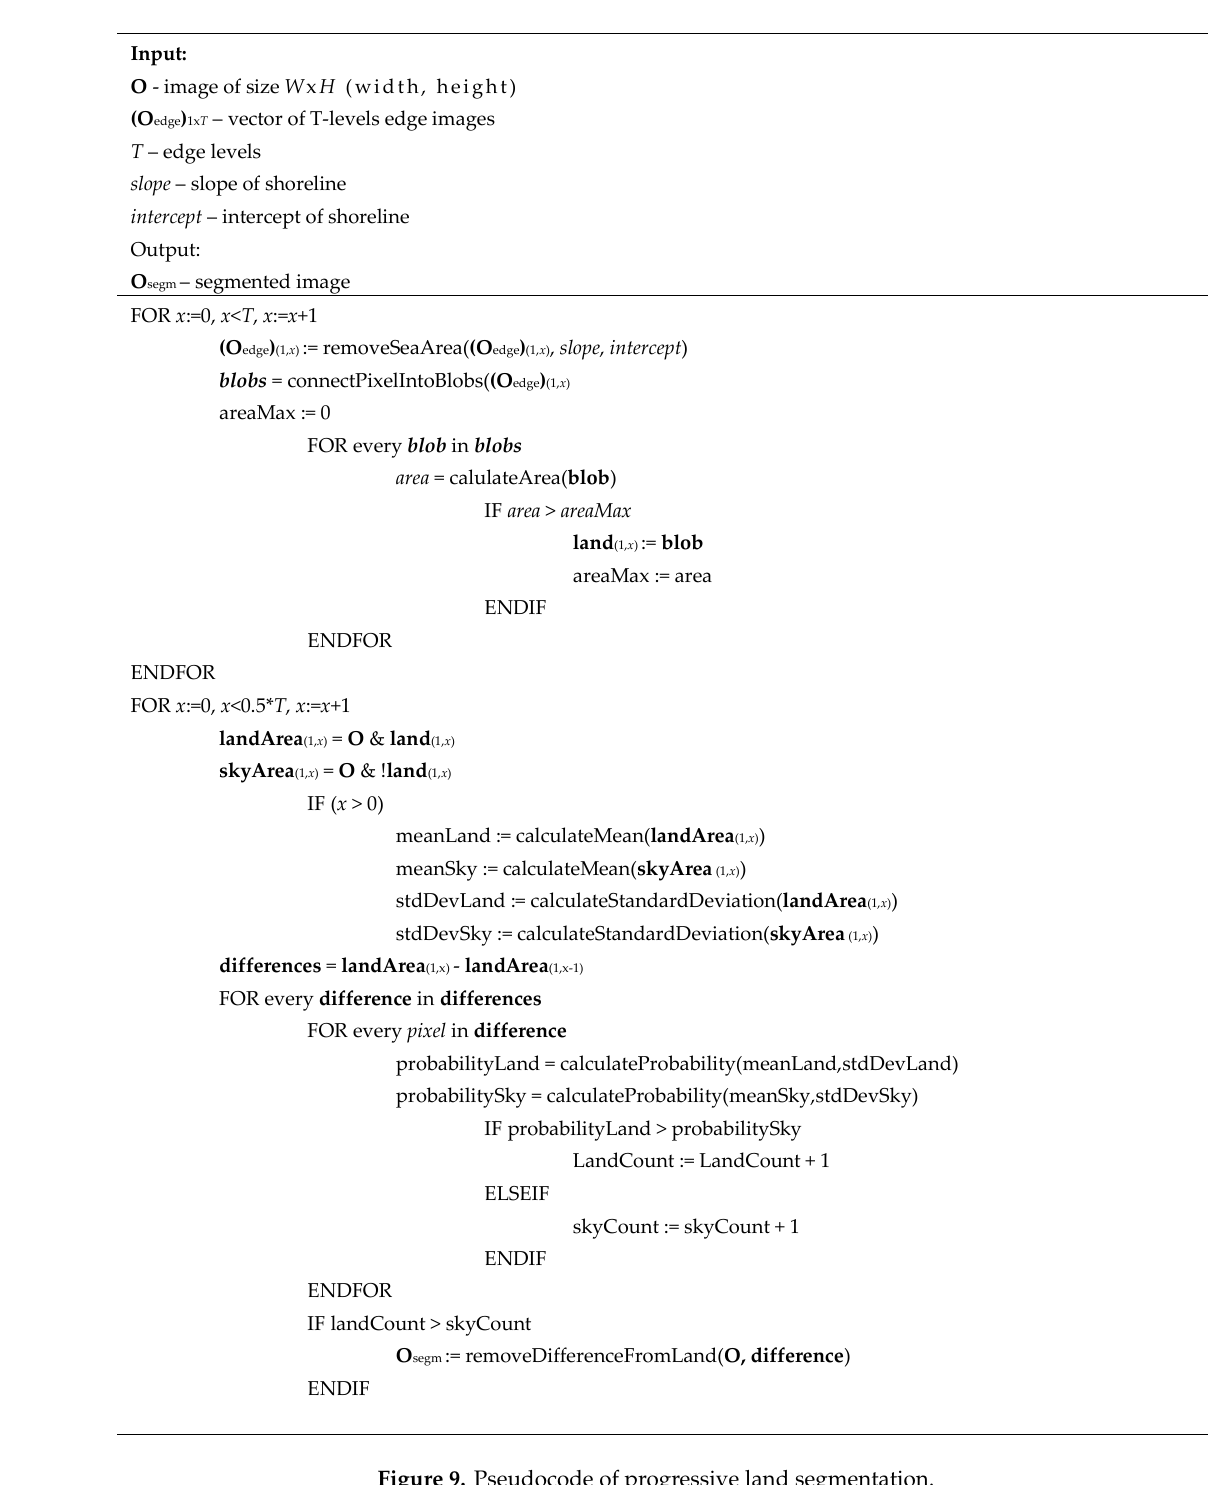
Figure 9. Pseudocode of progressive land segmentation.